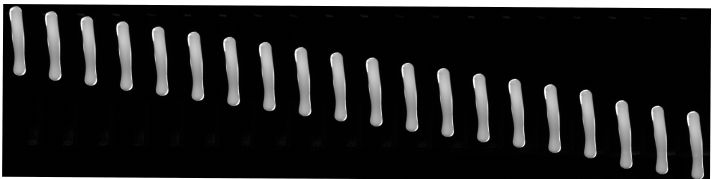
Figure 12. Images of free-falling glass gob from